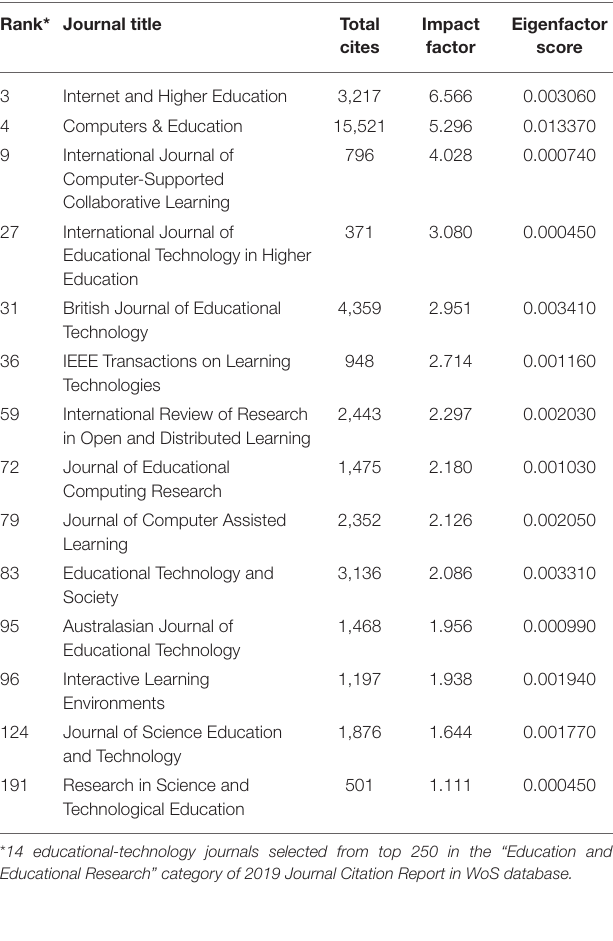
TABLE 2 | The selected educational-technology journal list.